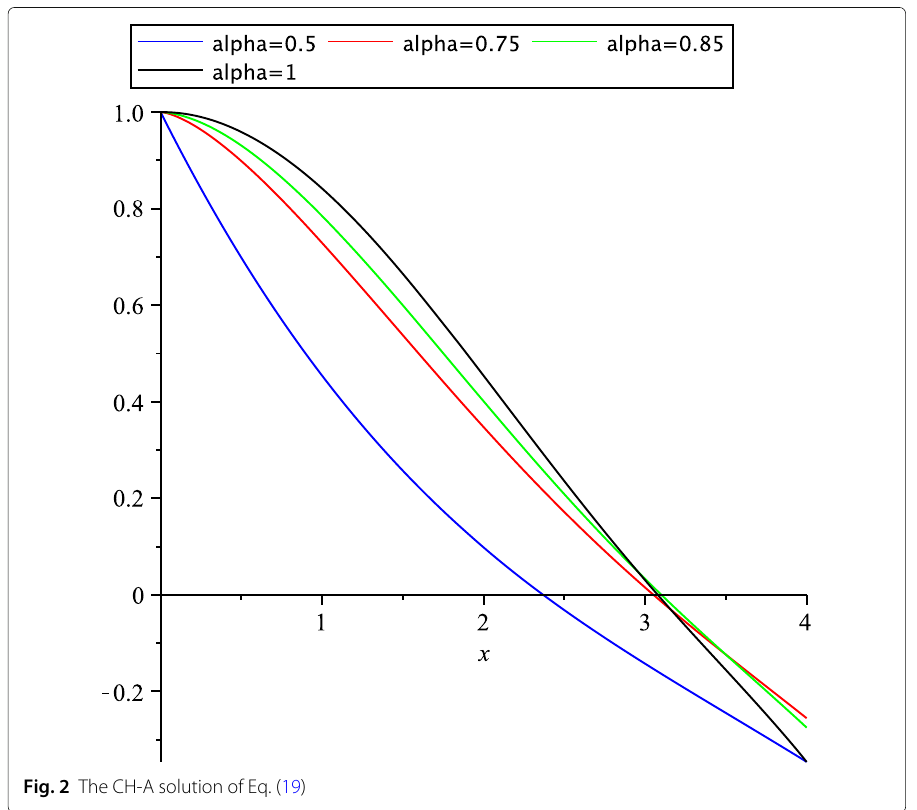
Fig. 2 The CH-A solution of Eq.